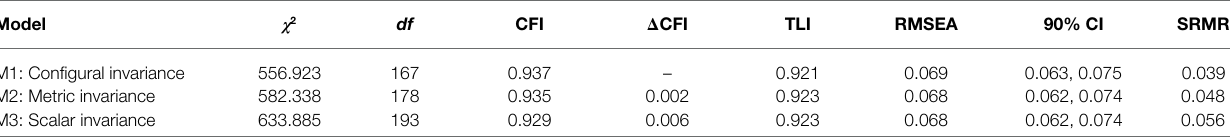
TABLE 3 | Testing first-order factor loadings and item intercepts across genders. Model χ 2 df CFI Δ CFI TLI RMSEA 90% CI SRMR M1: Configural invariance